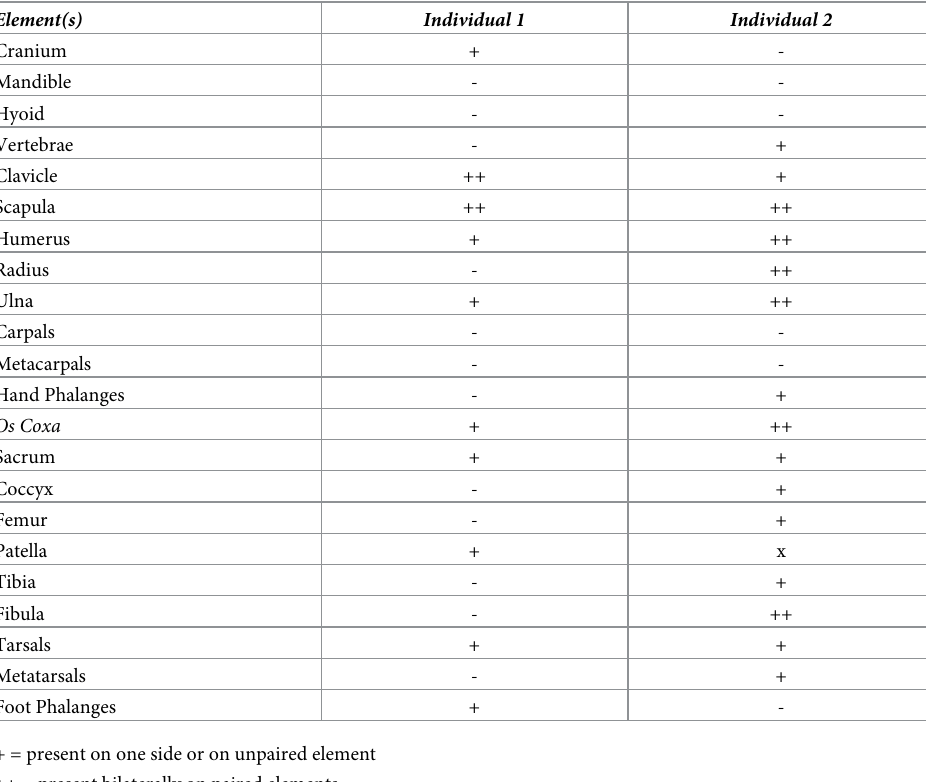
Table 1. Locations of periosteal and porous lesions on Individuals 1 and